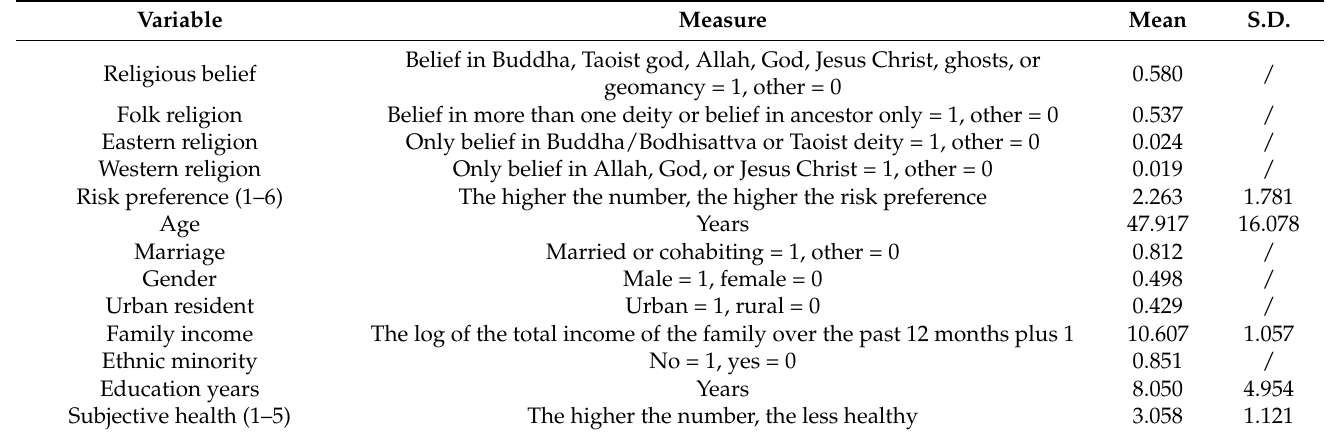
Table 1. Descriptive information for variables in the CFPS 2018 survey (N =